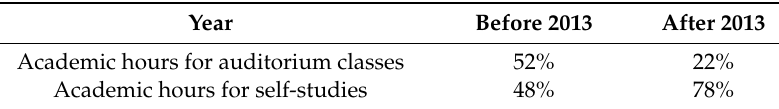
Table 1. Distribution of the academic hours in English in Master programmes in “MATI-Russian State Technological